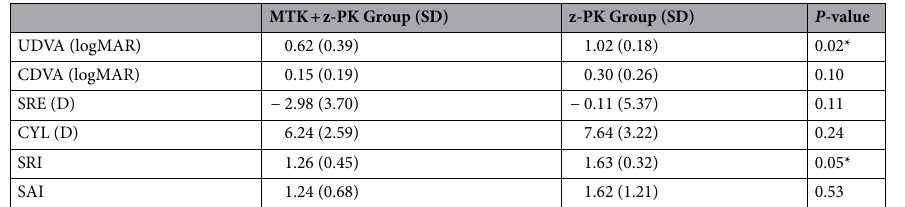
Table 2. Comparison of the postoperative outcomes between the MTK + z-PK group and z-PK group at 6-months postoperative. MTK microwave thermokeratoplasty, z-PK zig-zag penetrating keratoplasty, SD standard deviation, UDVA uncorrected distance visual acuity, logMAR logarithm of the minimum angle of resolution, CDVA corrected distance visual acuity, SRE spherical equivalent refractive error, D diopters, CYL topographic astigmatism cylinder, SRI surface regularity index, SAI surface asymmetry index. *There was a significant difference when tested with the Student’s t-test.